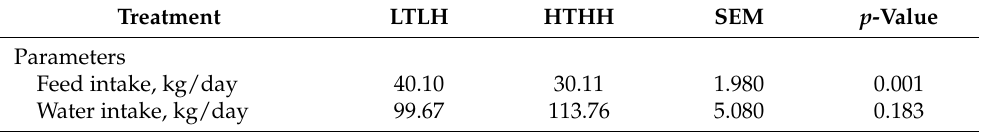
Table 2. Feed and water intake in dairy cows exposed to two distinct environmental conditions.